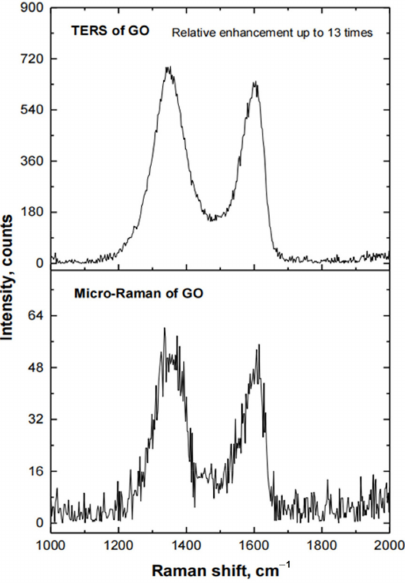
Figure 7. Raman spectra of GO, when the all-metal Au probe is in contact with the surface of Si substrate, coated with a film of GO (TERS of GO), and when the Au probe is retracted from the surface of this substrate (Micro-Raman of